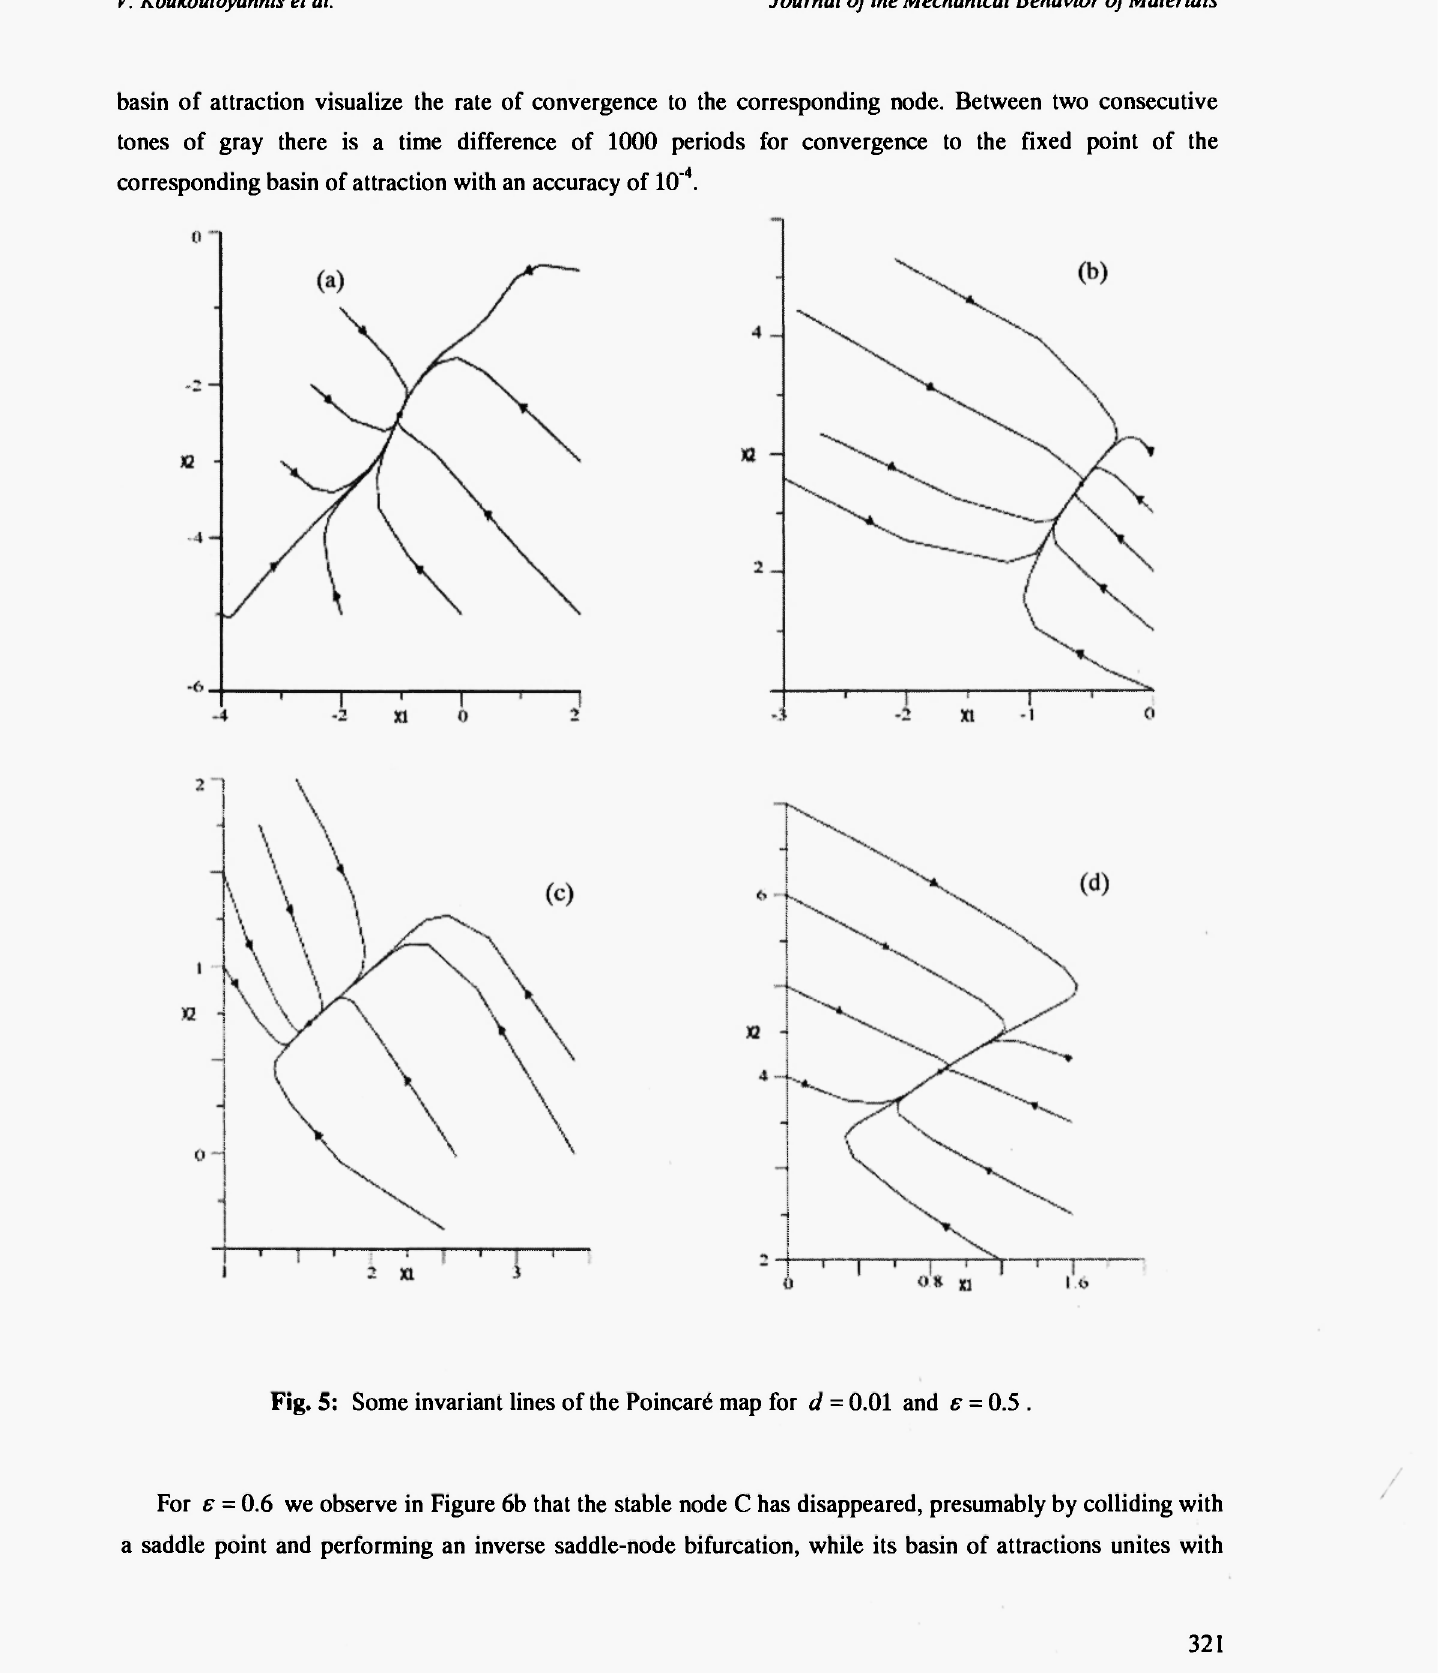
For ε = 0.6 we observe in Figure 6b that the stable node C has disappeared, presumably by colliding with a saddle point and performing an inverse saddle-node bifurcation, while its basin of attractions unites with